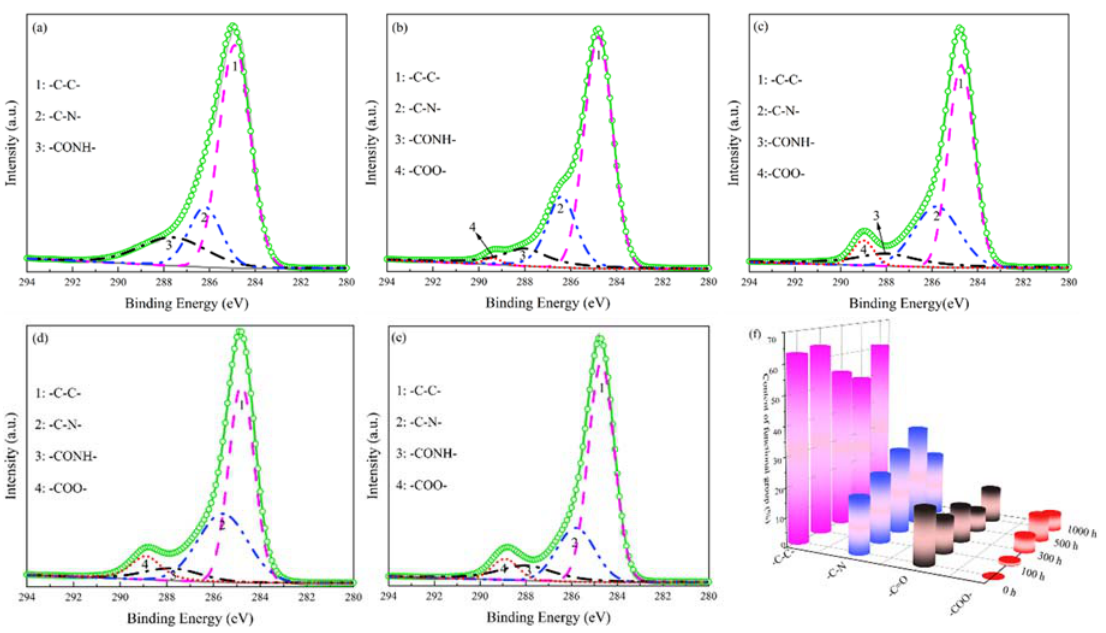
Figure 10. High-resolution XPS spectra for Kevlar fibers before ( a ), and after ozone exposure to atomic oxygen for 100 h ( b ), 300 h ( c ), 500 h ( d ), 1000 h ( e ) and content of functional group of C1s peaks for Kevlar fibers ( f ). Table 3. Functional groups on the Kevlar fibers surface before and after ozone exposure. Exposure Time